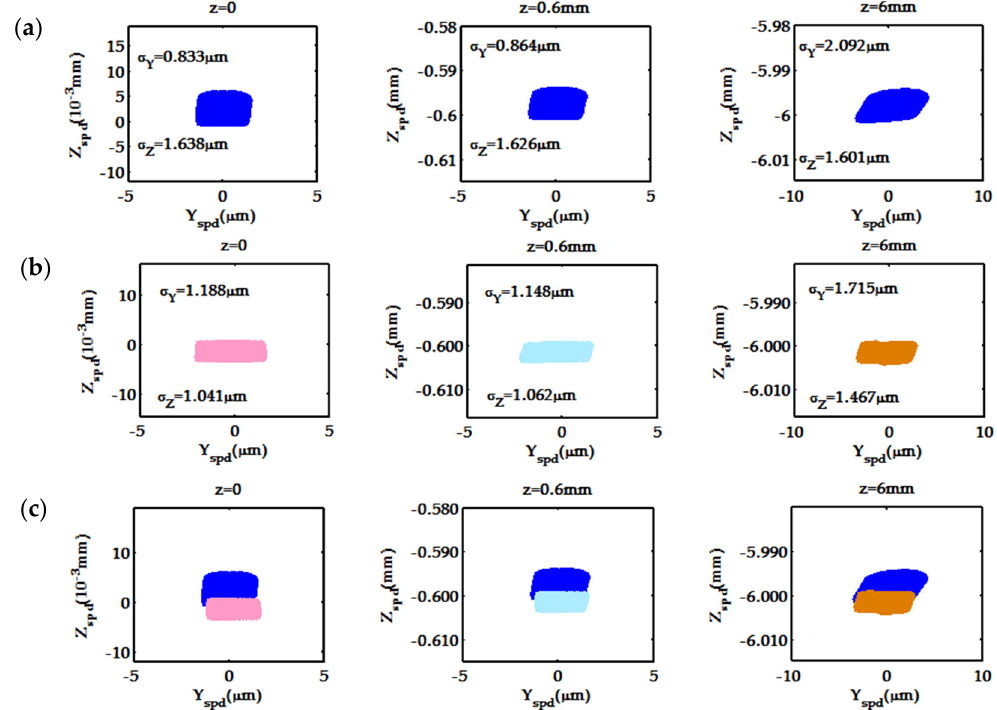
Figure 6. Spot diagrams constructed for the model optical system at λ = 700 nm with s = 0 from: ( a ) formulas (25) and (26); ( b ) ray tracing using ZEMAX; and ( c ) contrasted by overlaying ( a ) with ( b ).